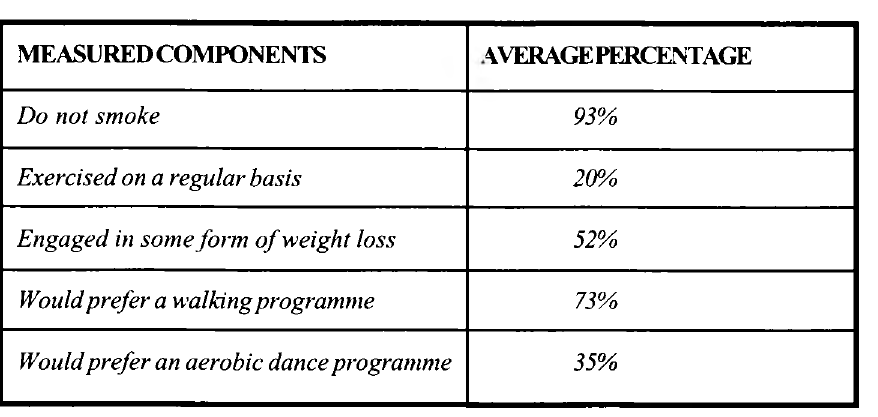
Table 2 The percentage responses to selected questions